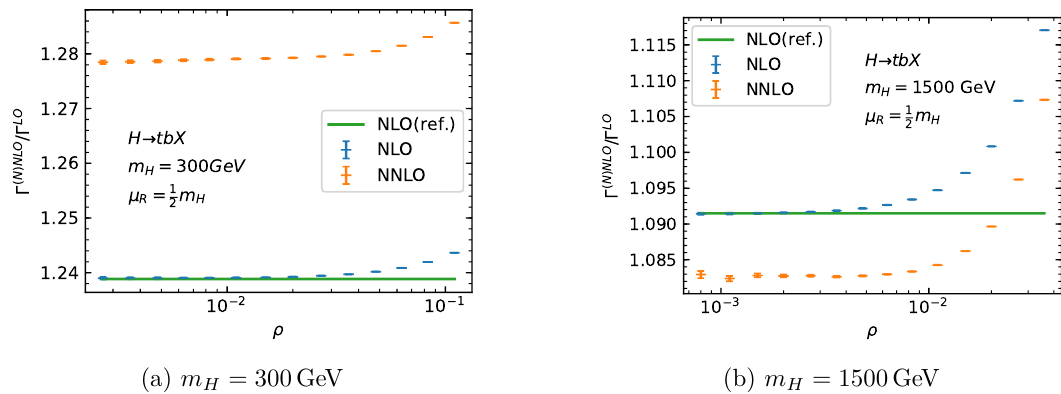
Figure 1. Dependence of the partial decay width on the phase space slicing parameter cut-off ρ cut for a 300 GeV (left) or a 1500 GeV (right) charged Higgs boson decaying into a top quark and jets. The ρ parameter is defined in eq. (2.3). The green horizontal lines represent the analytical predictions of the NLO partial decay width. The blue (orange) scatter points with error bars represent our NLO (NNLO) predictions. The renormalization scale is set to the half of the charged Higgs boson mass. All predictions are normalized to the LO partial width Γ LO with m H = 300 GeV (left) or H → tb 1500 GeV